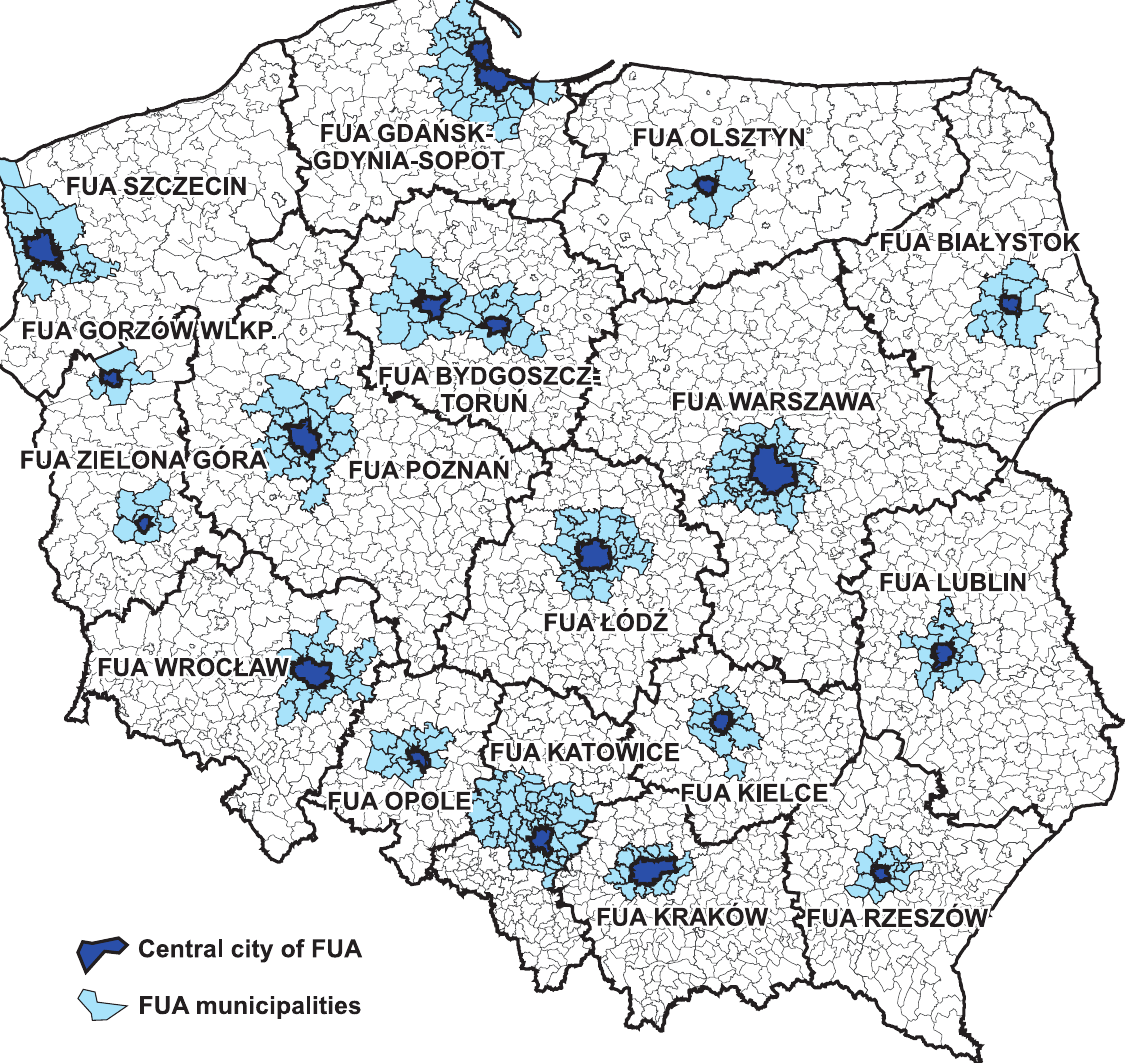
Fig. 2. Range of ITI unions in functional urban areas (source: own study based on the ITI strategies of voivodeship centres). source: own